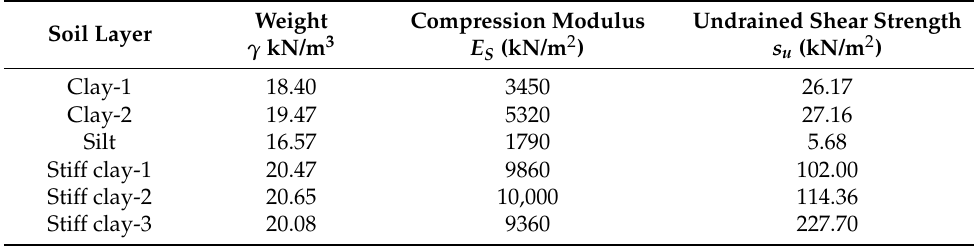
Table 1. Marine soft clay physical properties.